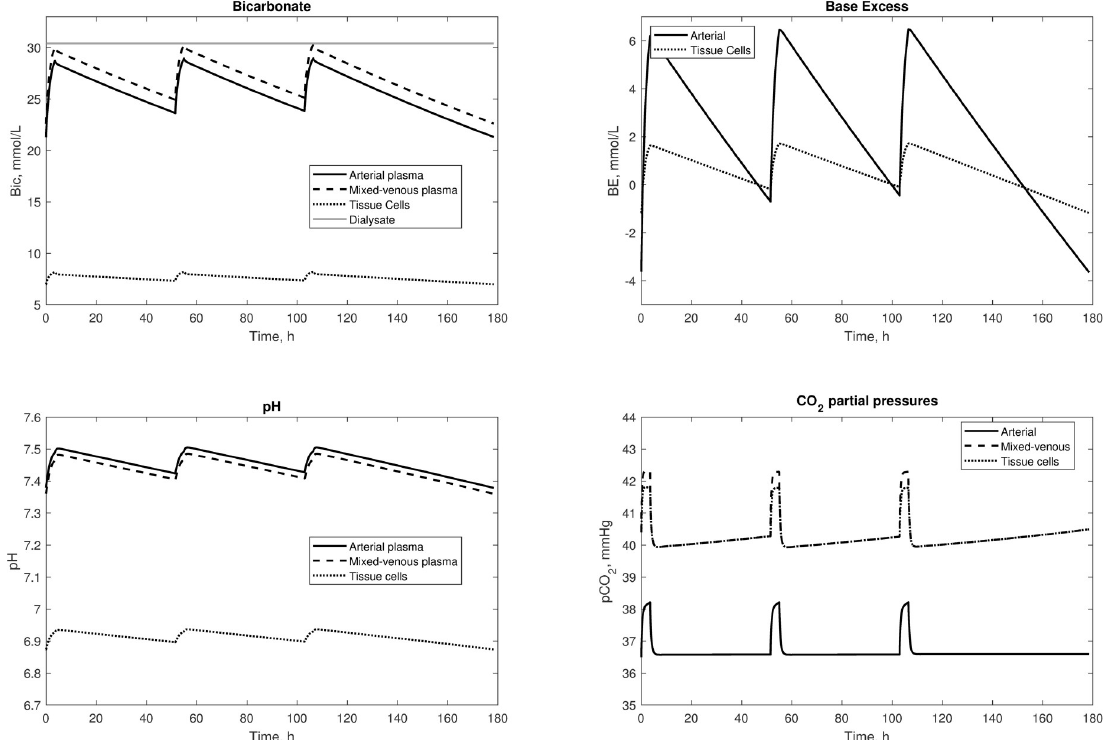
Fig 5. Simulations of a week-long cycle of HD sessions. Two postdialytic intervals were of 48 hours and one was of 72 hours, during which fluid volumes accumulates and bicarbonate buffer is depleted due to an endogenous acid production rate of 0.039 mmol/day per Kg of body mass. The dialysate concentration of bicarbonate was corrected for the Gibs-Donnan effect.